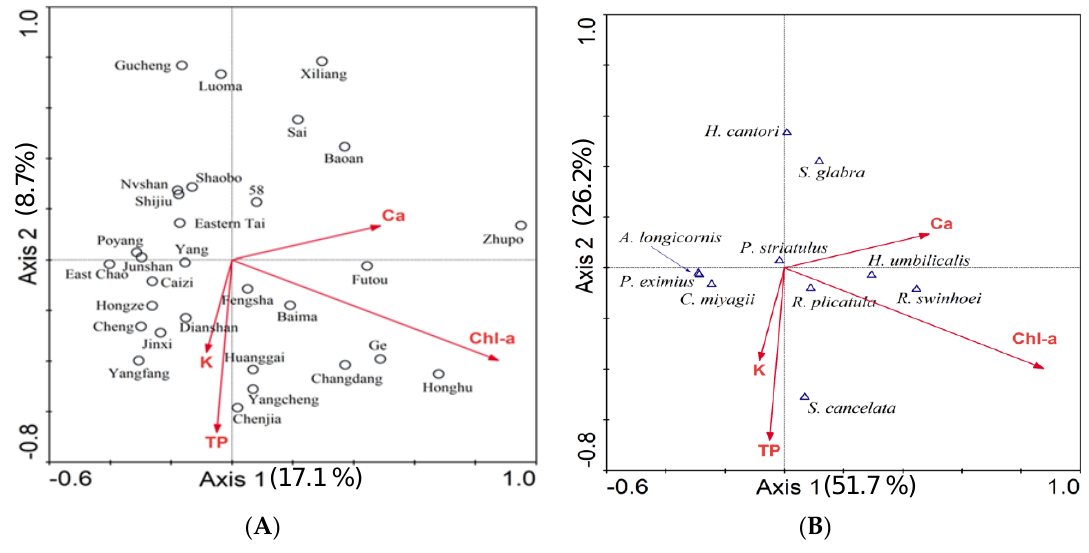
Figure 7. ( A ) Biplots of canonical correspondence analsysis (CCA): Samples vs. environmental variables in 30 surface sediment samples. The cumulative percentage variance of species data (%) are shown in Axis 1 and Axis 2; ( B ) Biplots of CCA: species of subfossil gastropods vs. environmental variables in 30 surface sediment samples. Cumulative percentage variance of species-environment (%) are shown in Axis 1 and Axis 2. Table 4. Summary of canonical correspondence analysis (CCA) forward selection of 11 species of gastropods in 30 sites.